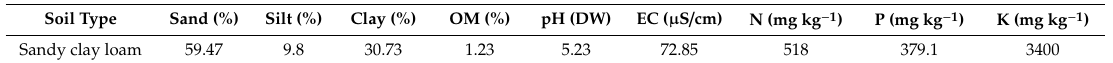
Table 1. Properties of the soil used in the